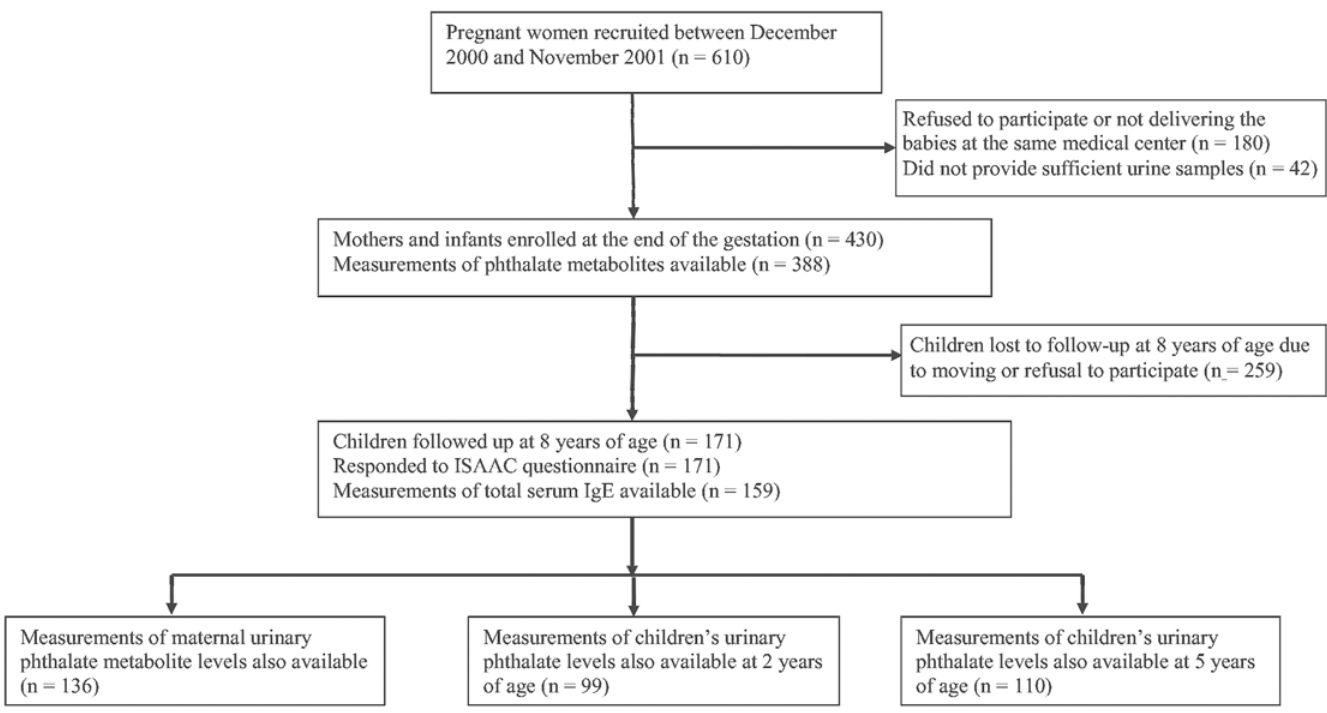
Fig 1. Flow chart of the recruitment process of pregnant women and follow up of their children. Pregnant women were invited to participate in the study. During the follow-up period, phthalate metabolites present in maternal and children ’ s urine were measured. At 8 years of age, the presence of asthma and wheezing was assessed using the International Study of Asthma and Allergies in Childhood (ISAAC) questionnaire.